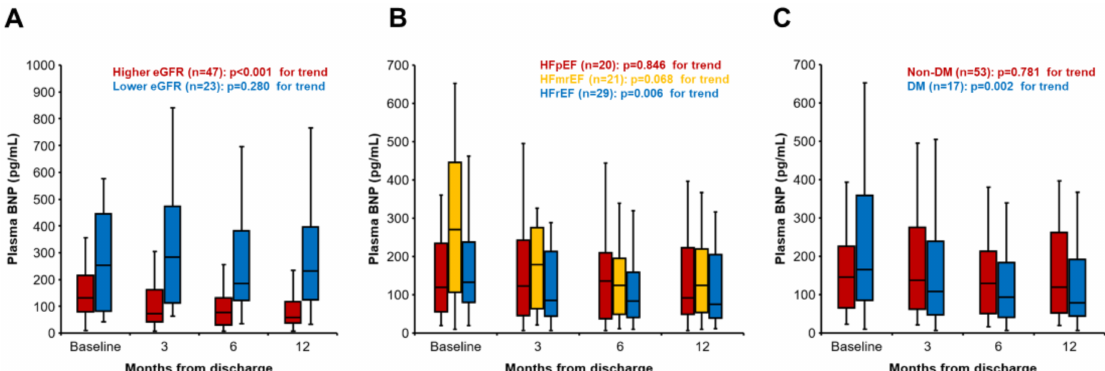
Figure 5. Changes in plasma B-type natriuretic peptide (BNP) level during the observational period. ( A ) Stratified by baseline estimated glomerular filtration rate (eGFR). ( B ) HFrEF/HFmrEF/HFpEF cohort. ( C ) DM/non-DM cohort. Variables were expressed as median and